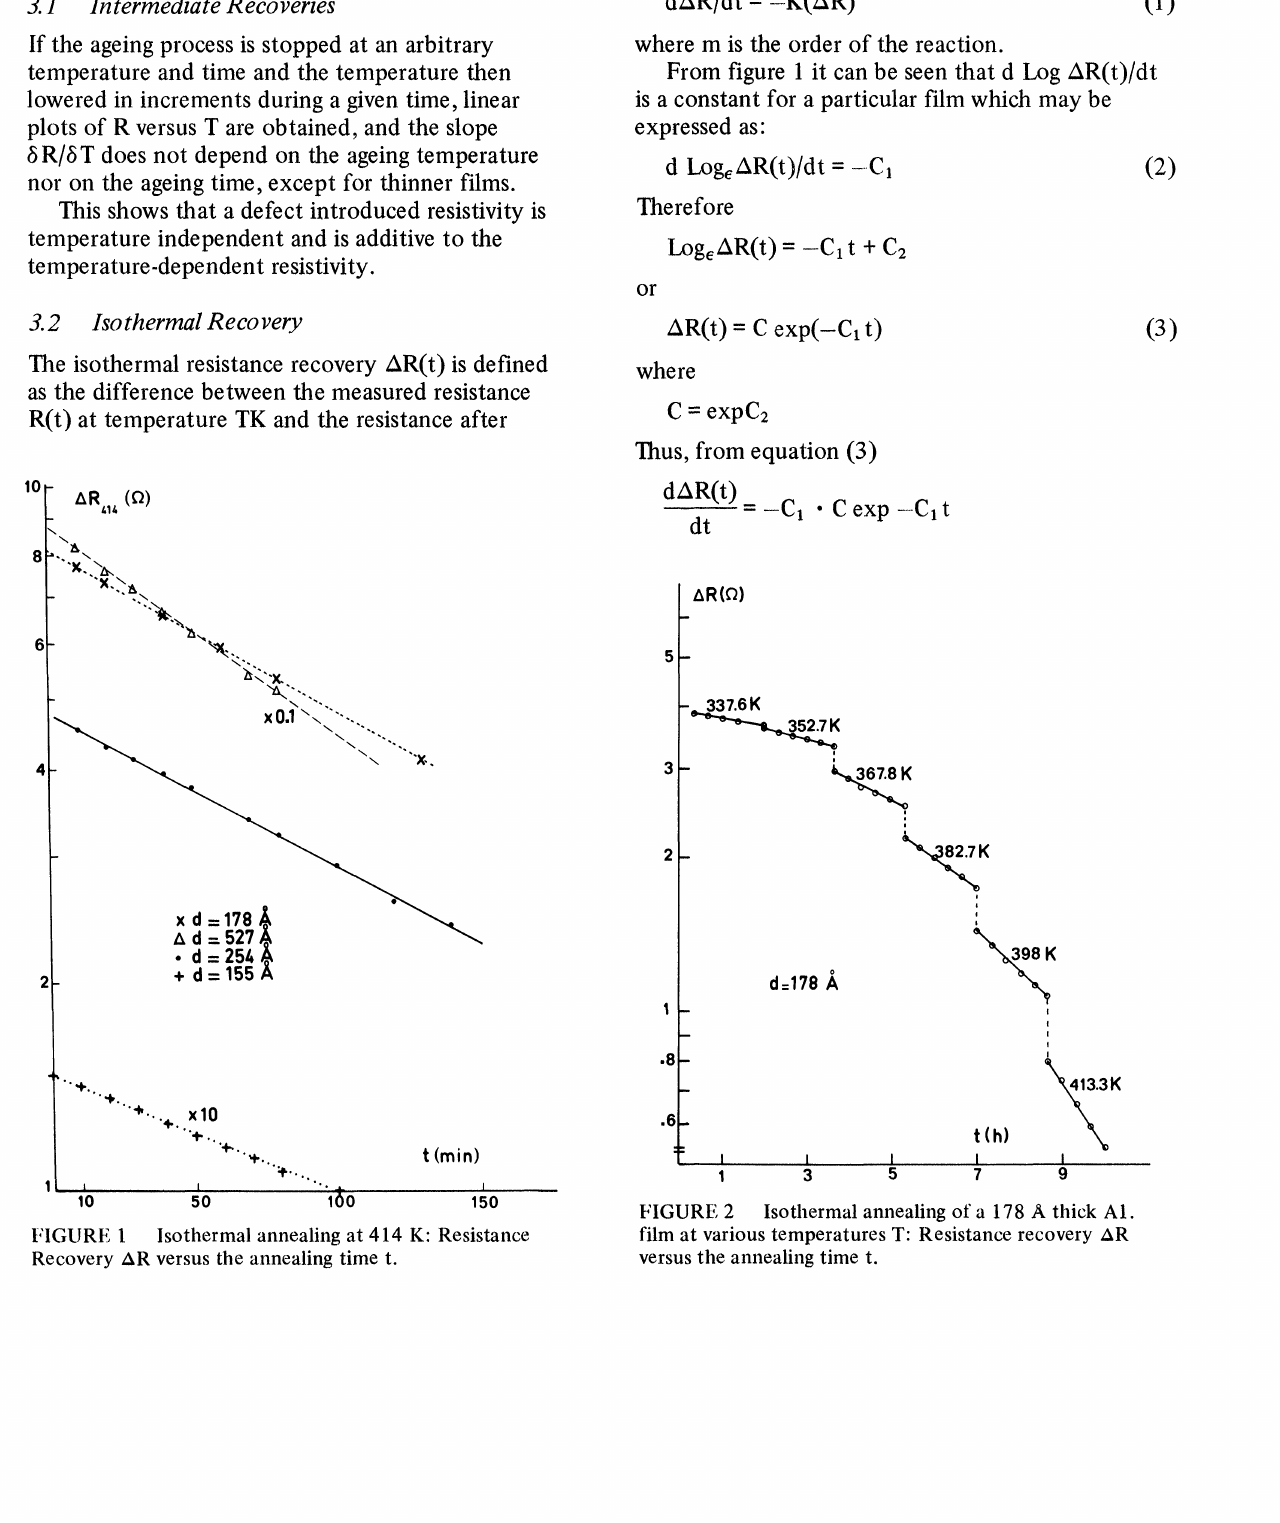
Isothermal annealing of a 178 A thick AI. film at various temperatures T: Resistance recovery AR versus the annealing time